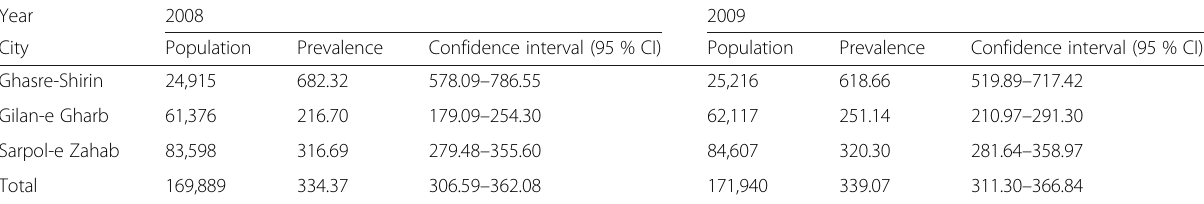
Table 2 The prevalence of scorpion stings per 100,000 people and its confidence interval in the tropical area of Kermanshah